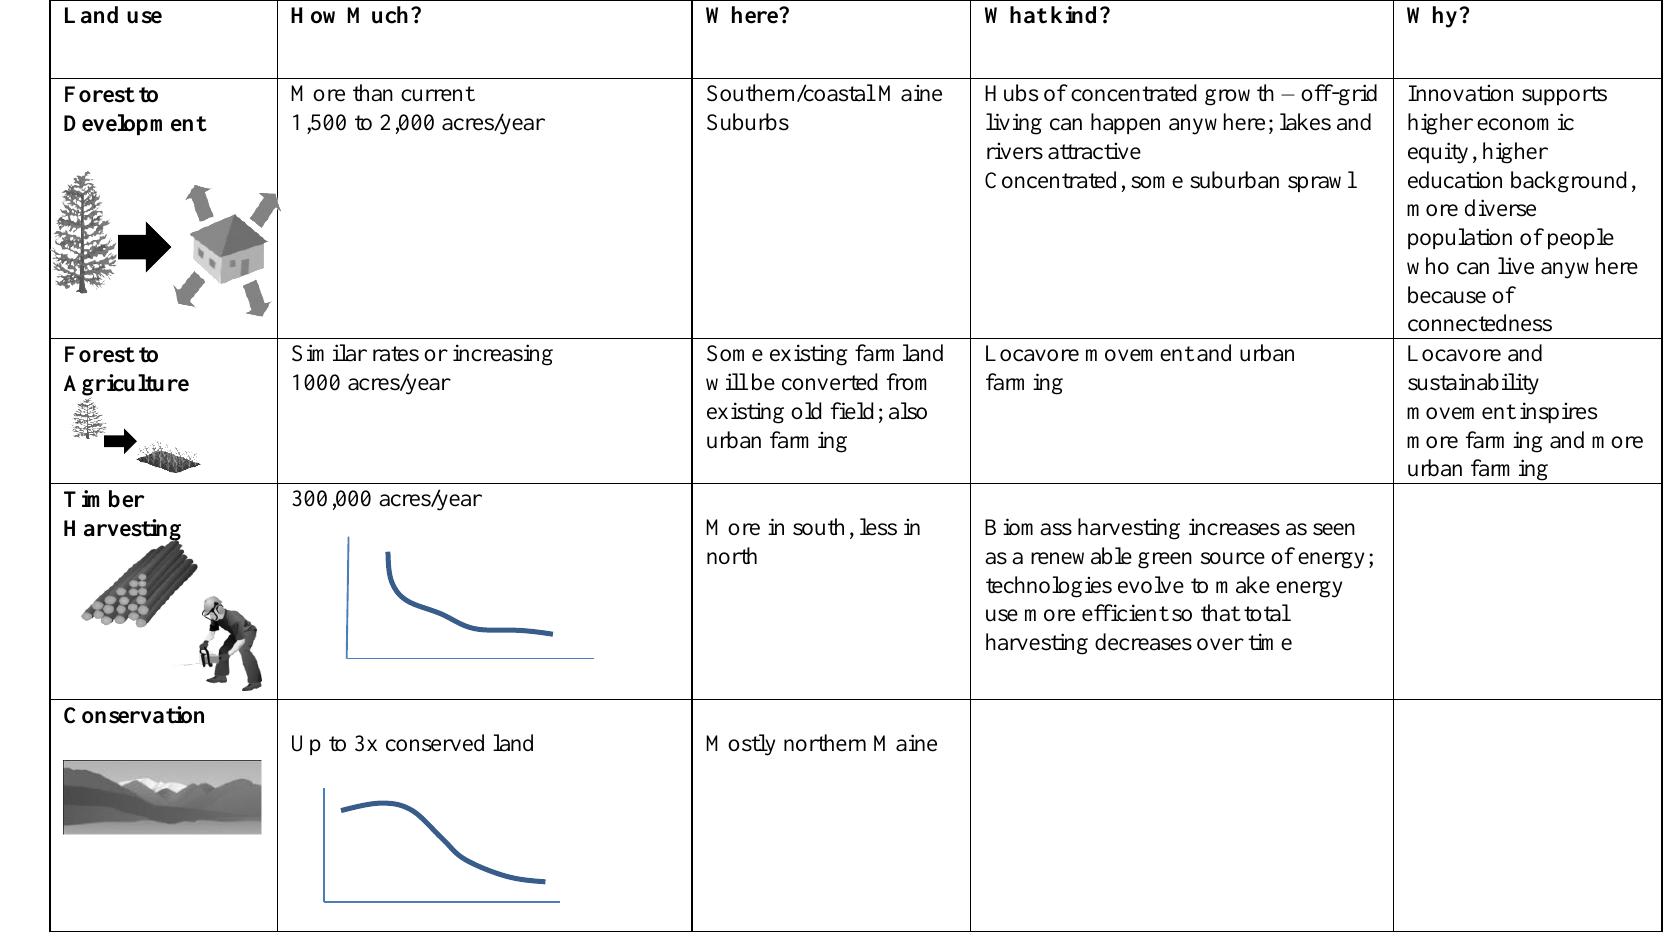
Table A2.10. Scenario 2: Yes We Can Land